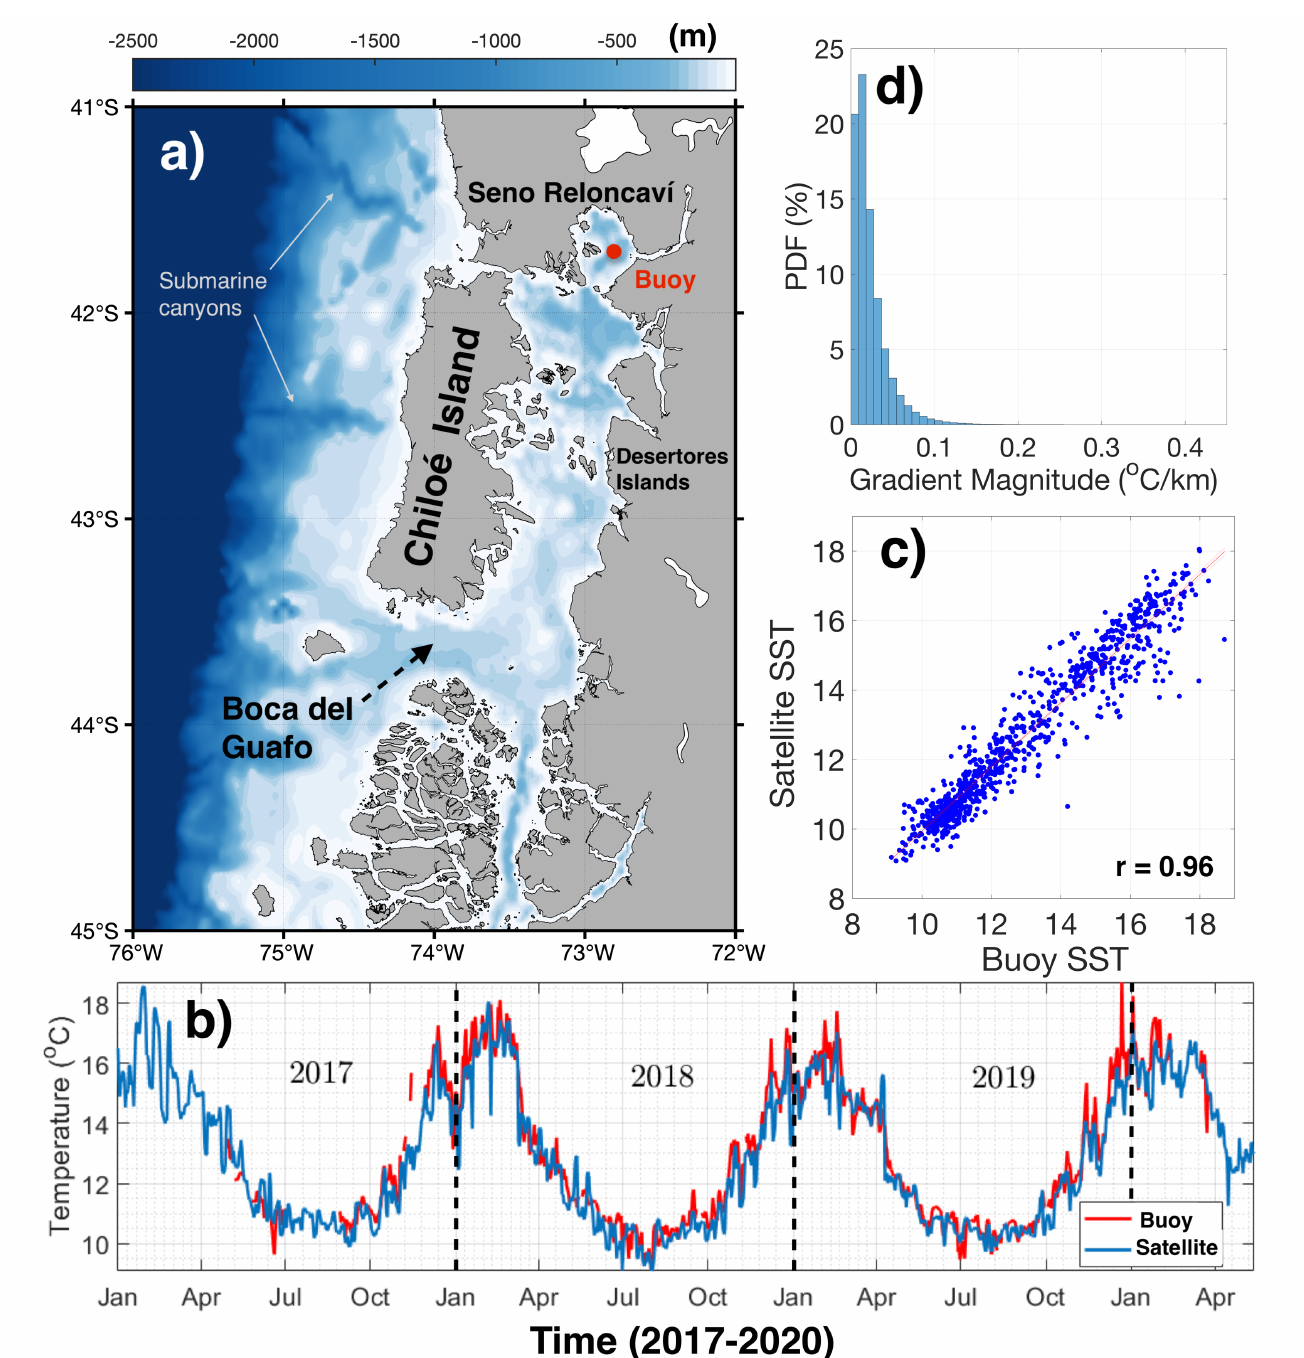
Figure 1. ( a ) Map of the Inner Sea of Chiloé and its adjacent coastal ocean in northern Patagonia. The bathymetry is shown in a blue-white color scale. The position of the oceanographic buoy located in Seno Reloncaví is denoted by a red dot. The comparison between satellite SST and near-surface (1 m) temperature at the buoy is presented in ( b , c ). In situ temperature has been daily averaged to match satellite SST data. ( d ) Probability Density Function (in %) of the distribution of all SST gradient magnitudes for the period